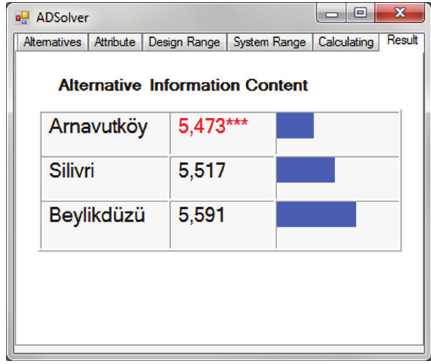
Figure 10: Solution of the ADSolver for weighted AD